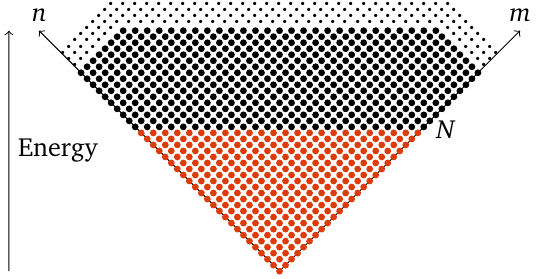
Figure 4: The spectrum (9) of LLL states (10) in an isotropic trap (5). In contrast to the 2D QHE, degeneracies persist despite the trap: wavefunctions φ same value of m + n have the same energy. The red dots are states that contribute to the many-body ground state (11). This should be compared with the anisotropic spectrum in fig.